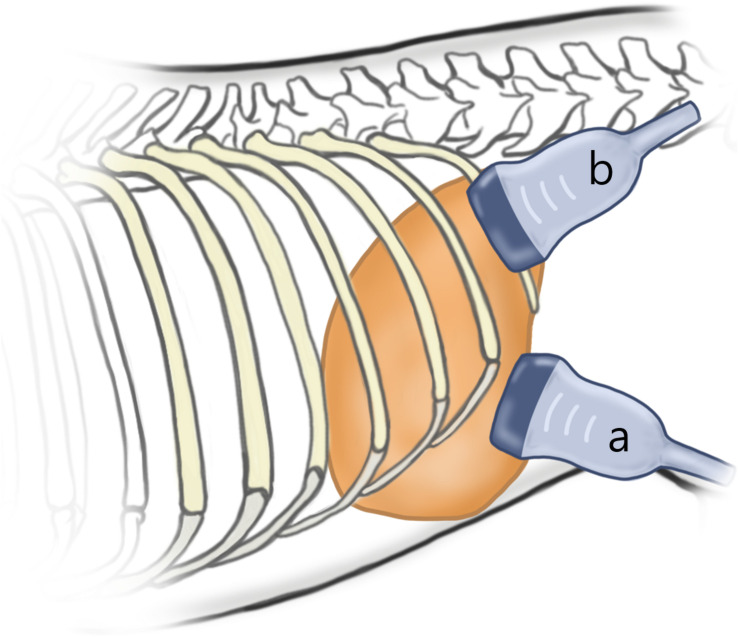
Schematic representation of the probe position according to the approach. For subcostal approach (a), the ultrasound probe is placed under the ribs. For intercostal approach (b), the probe was placed parallel to and within the intercostal space, and sufficient gel was applied to minimize rib shadowing.